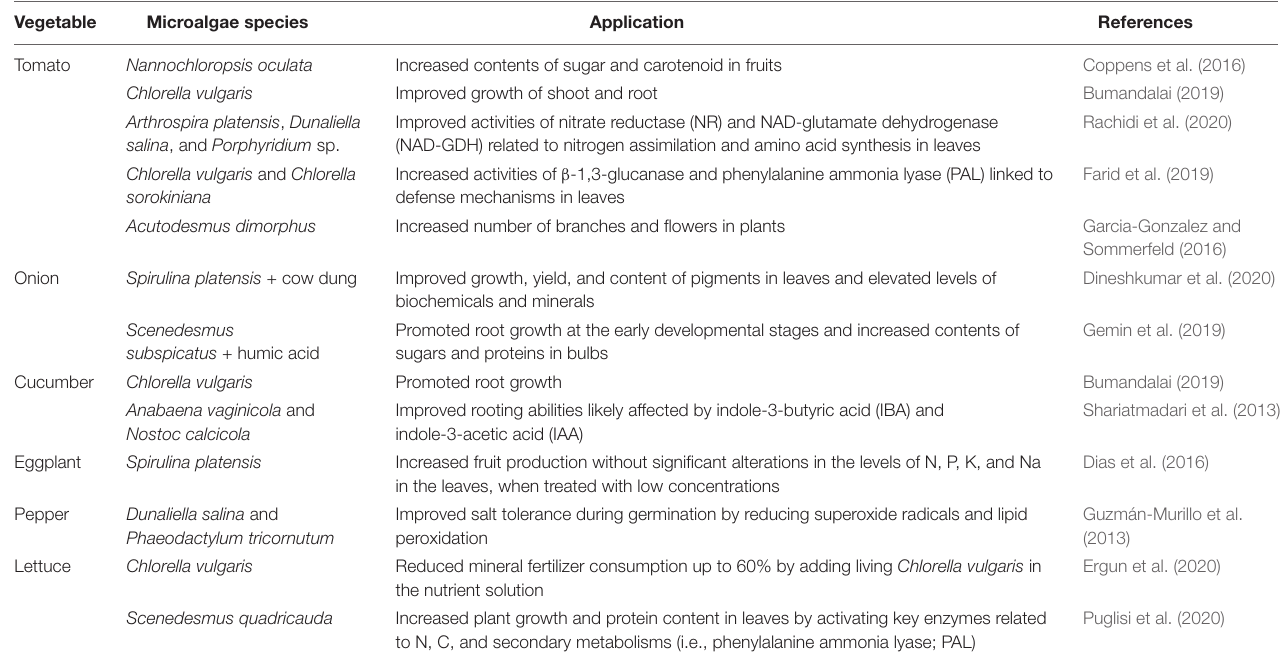
TABLE 1 | Typical cases of microalgal effects on vegetable